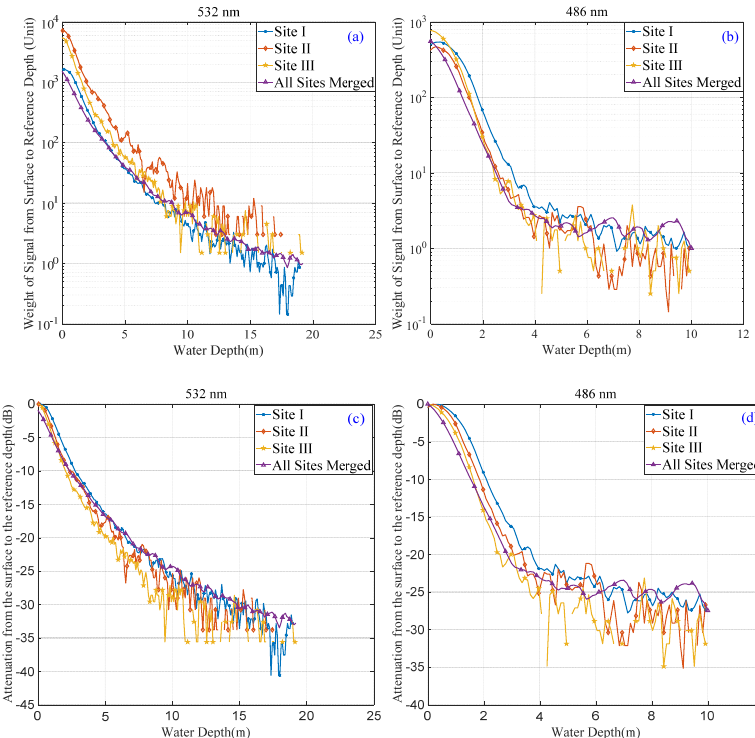
Figure 8. ( a ) Change in weight with water depth for 532 nm, relative to the reference depth; ( b ) change in weight with water depth for 486 nm relative to the reference depth; ( c ) attenuation of weight from the surface to the reference depth for the 532 nm channel; ( d ) attenuation of weight from the surface to the reference depth for the 486 nm channel.